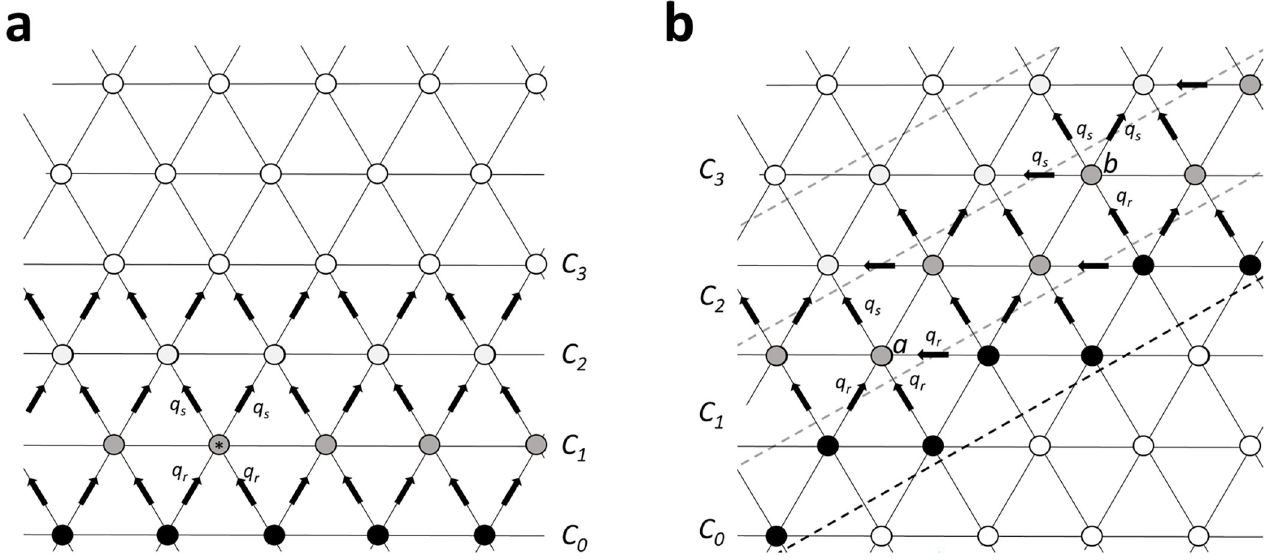
Fig 2. Geometric model of dye-transfer through coupled horizontal cells. (a) Cells located in C 1 ( � ) receive dye ( q r ) from two cells in C 0 and individually ) in C . (b) Cells located in C either receive input from three cells in C feed two cells ( q s 2 1 and feed three cells in C 2 (cell b